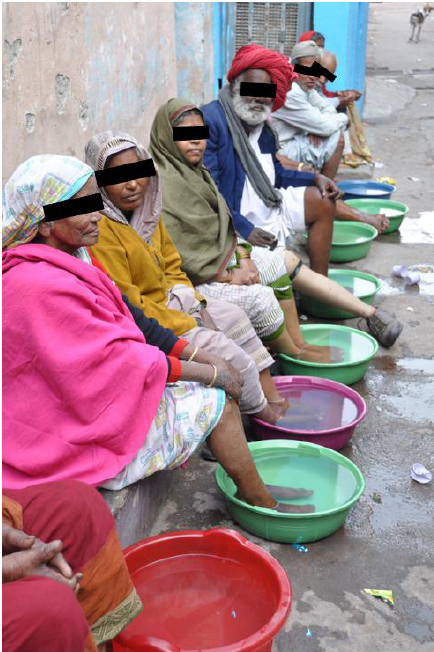
Figure 3. Education on self-skin care for prevention of disabilities (POD) for people affected by leprosy in a village in India.